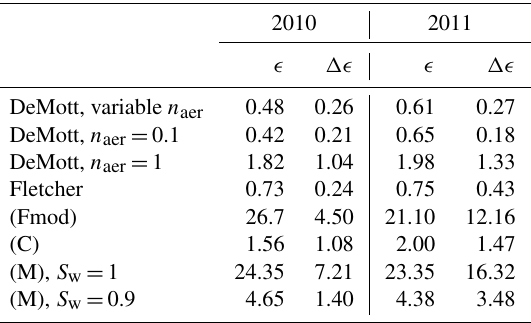
Table 7. The median of the flight-averaged (cid:15) = | INPparam − Obs | / Obs, and the corresponding median absolute deviation for dif- ferent INP parameterizations, for the two different years. DeMott refers to DeMott et al. (2010), and Fletcher to Fletcher (1962); see Table 3 for the other